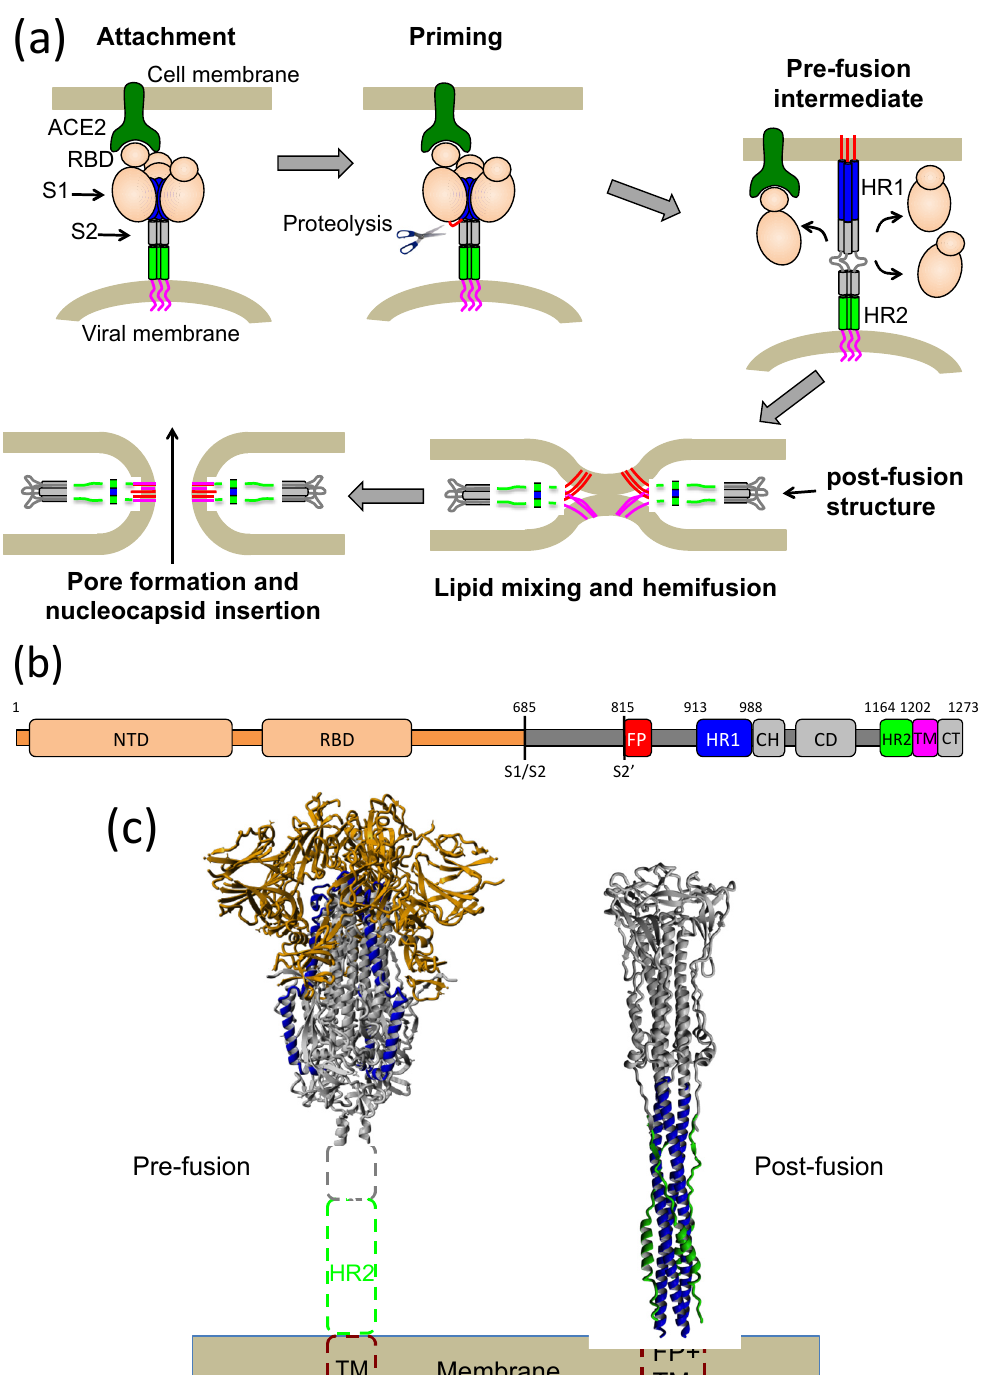
Figure 1. Mechanism of spike-mediated SARS-CoV-2 fusion. ( a ) Schematic representation of the putative steps of membrane fusion mediated by the spike protein. The HR1 and HR2 regions are indicated in blue and red, respectively, with the fusion peptide shown in red and the transmembrane region in magenta. ( b ) Primary structure of the full-length spike showing the sequence location of the various domains. S1/S2 and S2 ′ indicate the sites of proteolytic activation. ( c ) Structures of the prefusion spike in closed form and the S2 protein in post-fusion conformation. The models were built using the PDB entry 6VXX for the prefusion spike and 6M3W and 6LXT for the post-fusion structure. The dashed boxes indicate unresolved regions. The S1 subunits are indicated in orange in the prefusion structure. The HR1 and HR2 regions are indicated in blue and green, respectively, in each structure.